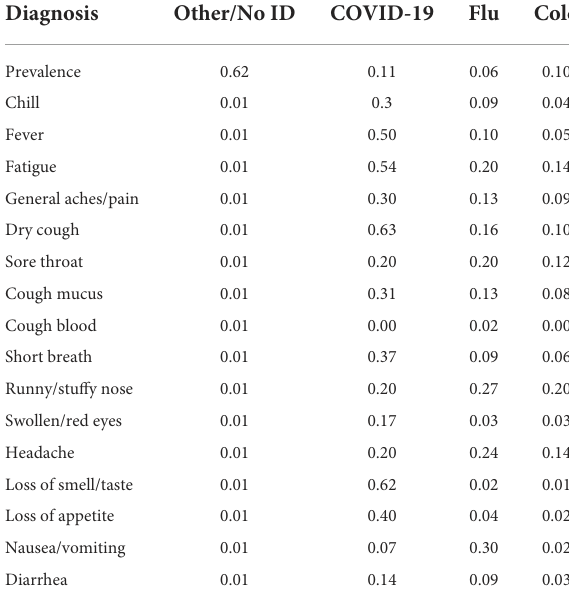
TABLE 1 The prevalence of each illness type and of reported symptoms per